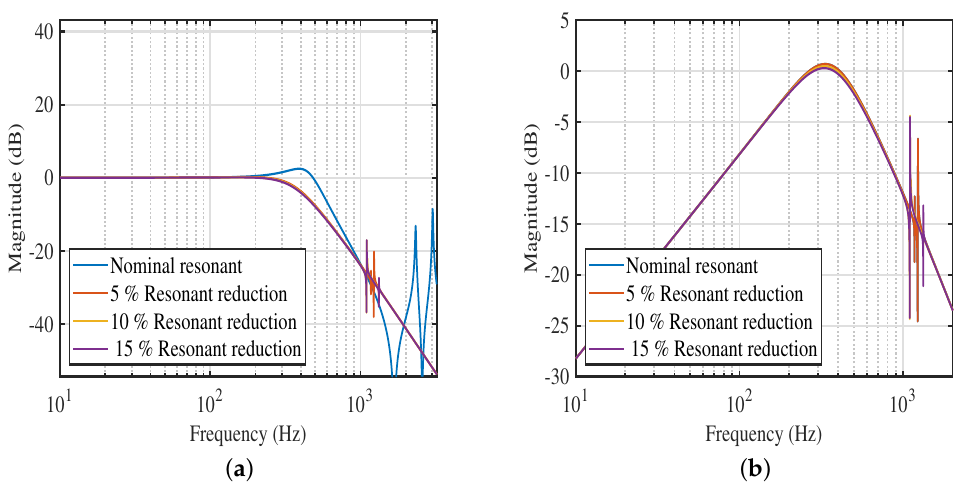
Figure 5. ( a ) Closed-loop magnitude response under resonant frequency changes for PPF scheme; ( b ) Disturbance rejection profile for various resonant frequency changes for PPF scheme.